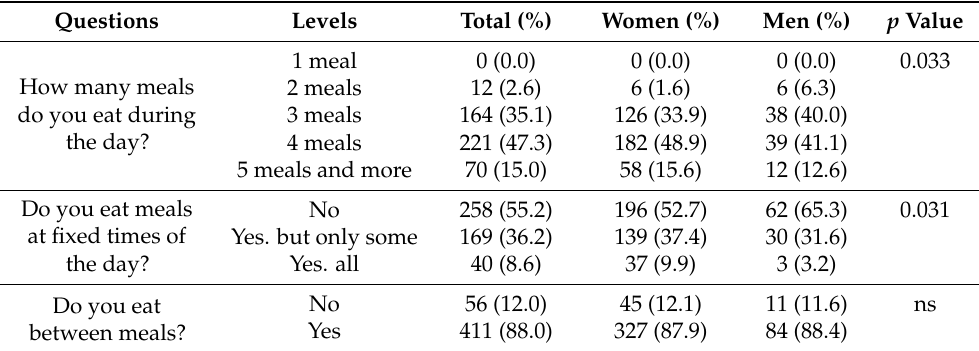
Table 3. Gender differences in the number, regularity of meals consumed and snacking of Polish young